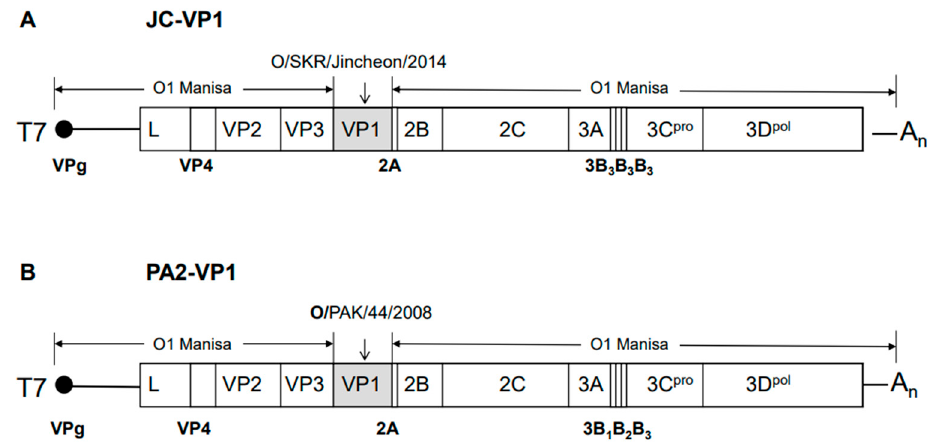
Figure 1. Schematic diagram of FMDV genomes with VP1 replacement for the development of a broad-spectrum vaccine strain. ( A ) JC-VP1, which has the P1 genome of O1 Manisa (VP4, 2, 3) and O/SKR/Jincheon/2014 (VP1), and ( B ) PA2-VP1, which has the P1 genome of O1 Manisa (VP4, 2, 3) and O PA2, O PAK/44/2008 (VP1). The 3B mutation of the 3B region was obtained using the same methods used in a previous report.